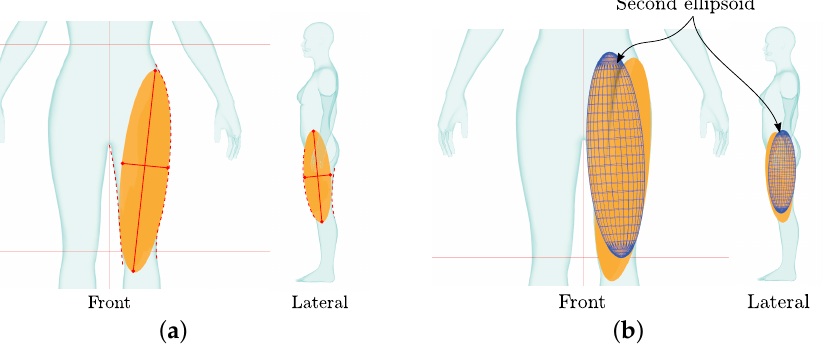
Figure 3. Approximation of the left thigh and hip with ellipsoids, front and lateral views. Red dotted line: surface boundary to approximate. ( a ) Approximation with one ellipsoid. ( b ) Improvement of the approximation with a second